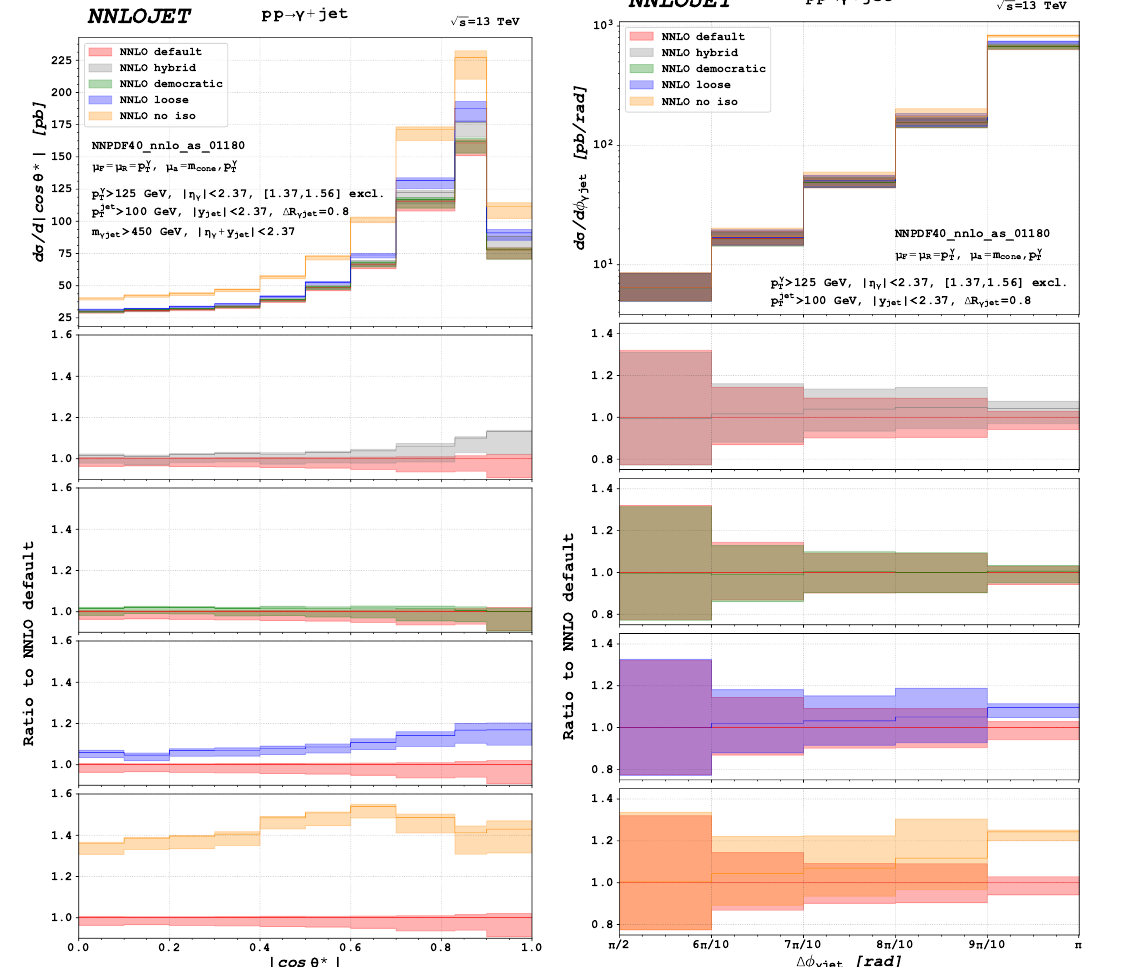
Figure 11. Predictions for the photon-plus-jet cross section differential in | cos θ ∗ | (left) and in the azimuthal angular separation between the photon and the jet (right) using different isolation